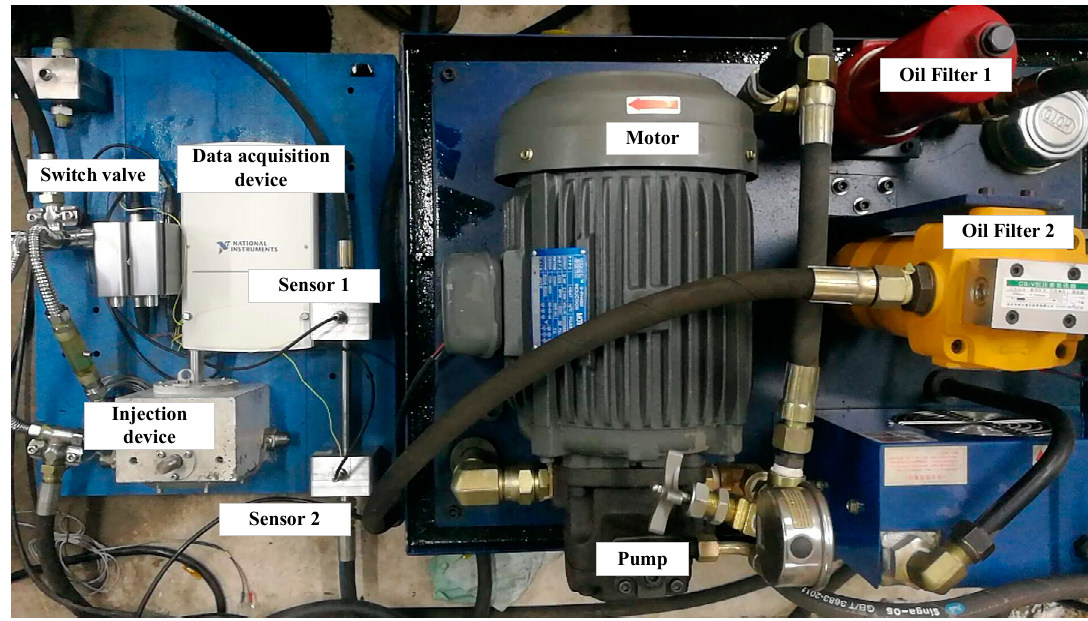
Figure 5. Experiment system.